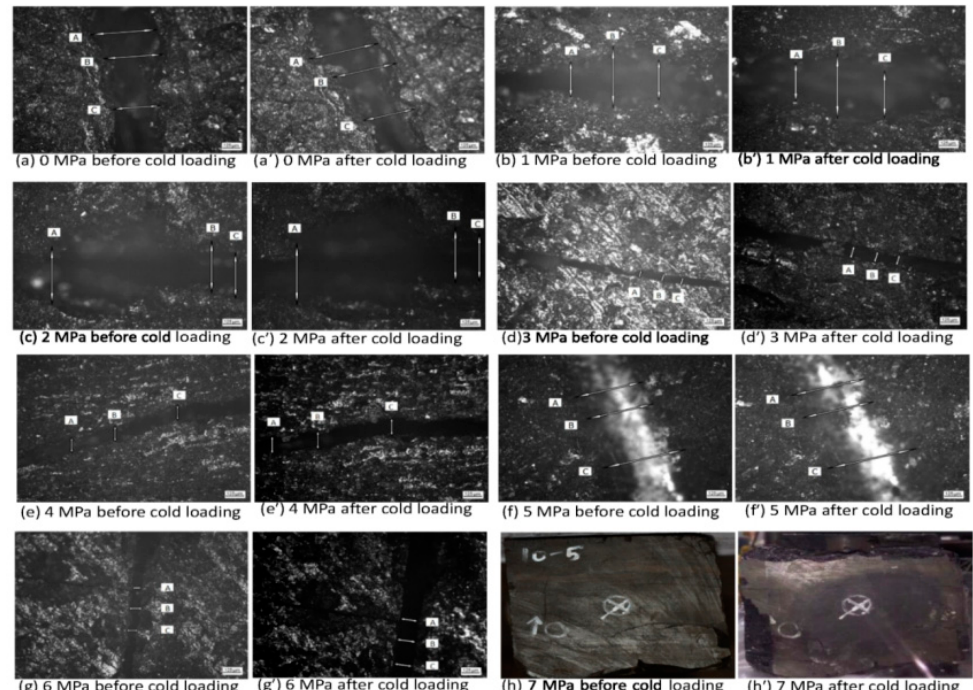
Figure 3. Surface fracture topography of coal samples under varied confining pressures after three periods of liquid nitrogen injection.